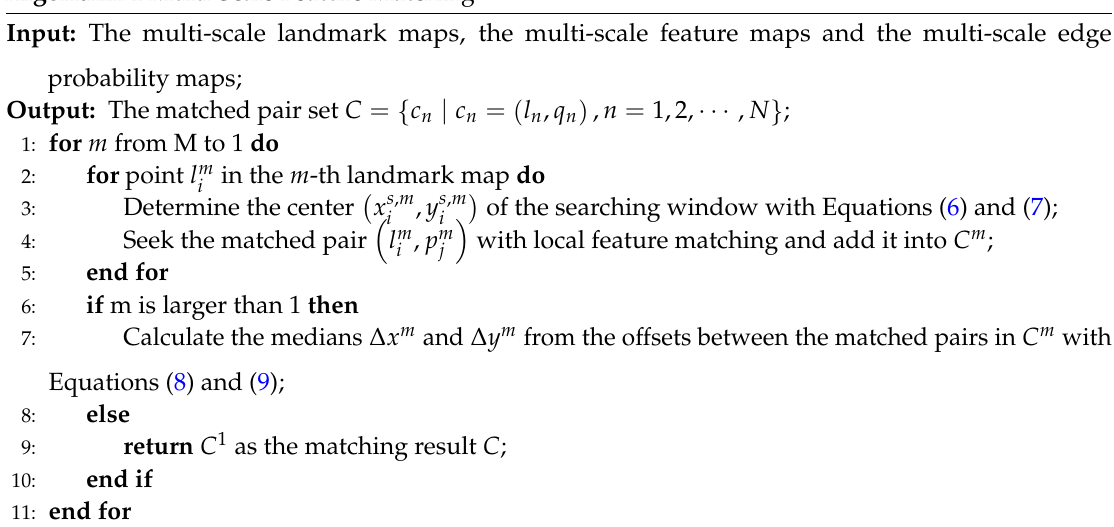
Algorithm 1 Multi-Scale Feature